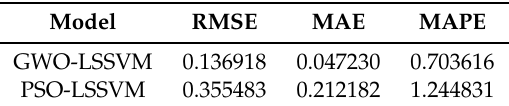
Figure 4. Product concentration prediction and error curve. Table 1. RMSE, MAE and MAPE